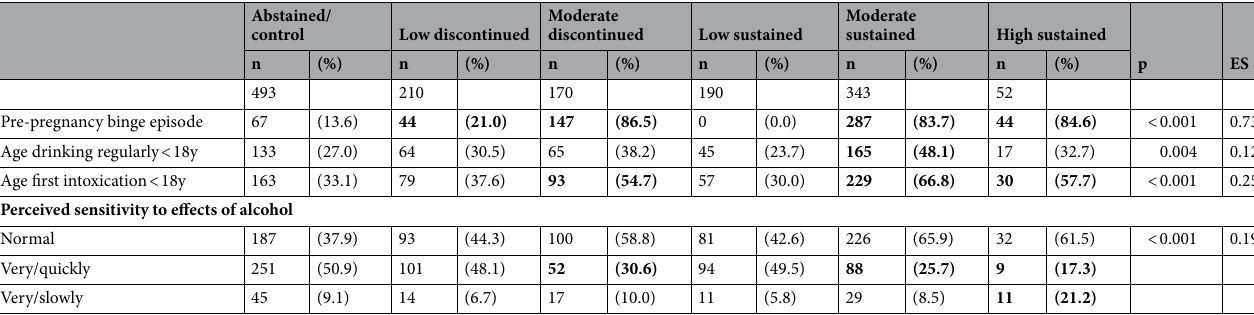
Table 3. Pre-pregnancy binge drinking, drinking age and alcohol sensitivity by trajectory. p = p -value, ES = effect size (Cramer’s V), boldface = statistically significant difference between group and